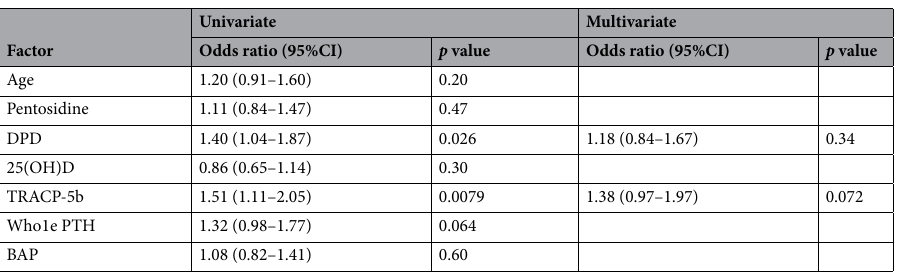
Table 5. Independent association between low BMD and bone markers in males. CI: confidence interval, DPD: deoxypyridinoline, 25(OH)D: 25-hydroxyvitamin D, TRACP-5b: tartrate-resistant acid phosphatase 5b, PTH: parathyroid hormone, BAP: bone alkaline